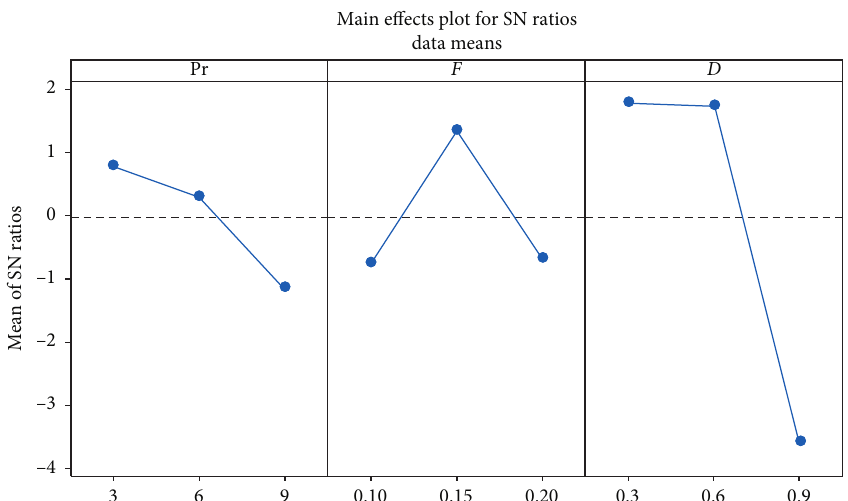
Figure 2: SN ratio-based important effect plot for wear on the tool; in the X -axis, Pr denotes pressure of cutting fluid (bar), F denotes feed (mm/rev), and D denotes depth of cut